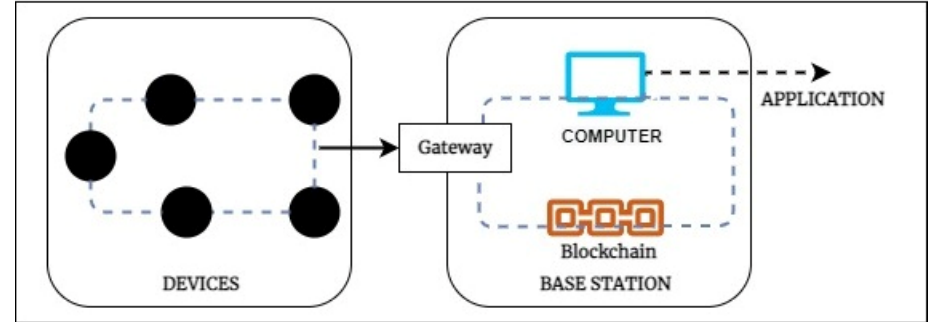
Figure 3. M2M base station.